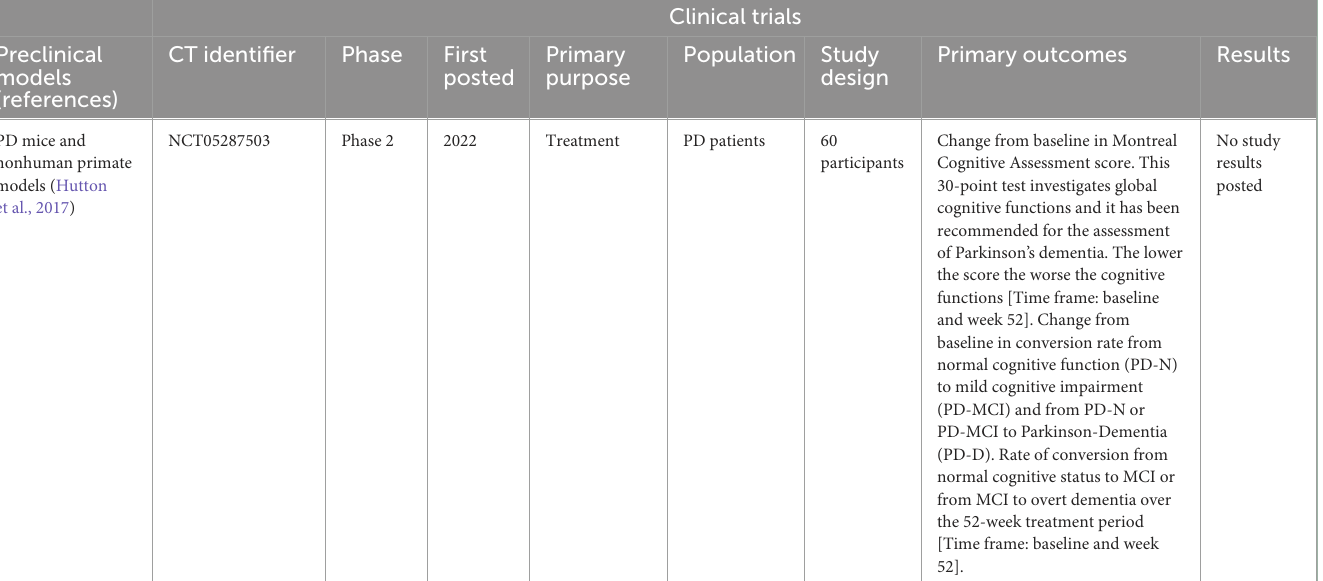
TABLE 3 Description of repurposed FDA-approved drugs for Parkinson’s disease of Huntington’s